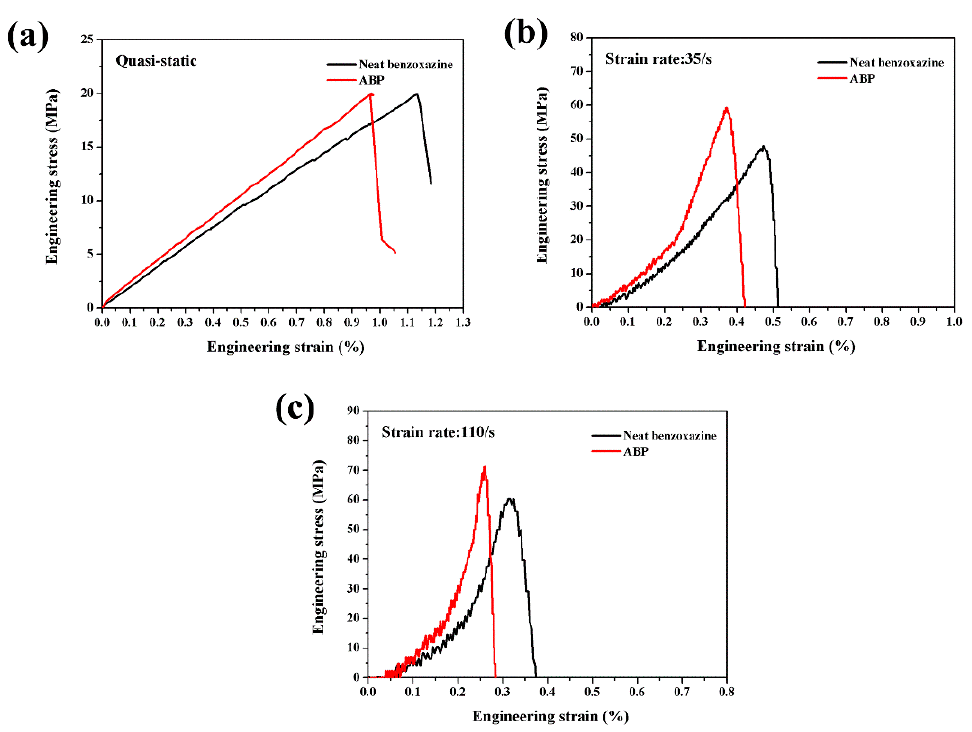
Figure 5. The tensile stress-strain curves of neat benzoxazine and its composite under different strain rates. ( a ) Quasi-static, ( b ) 35/s, ( c ) 110/s.